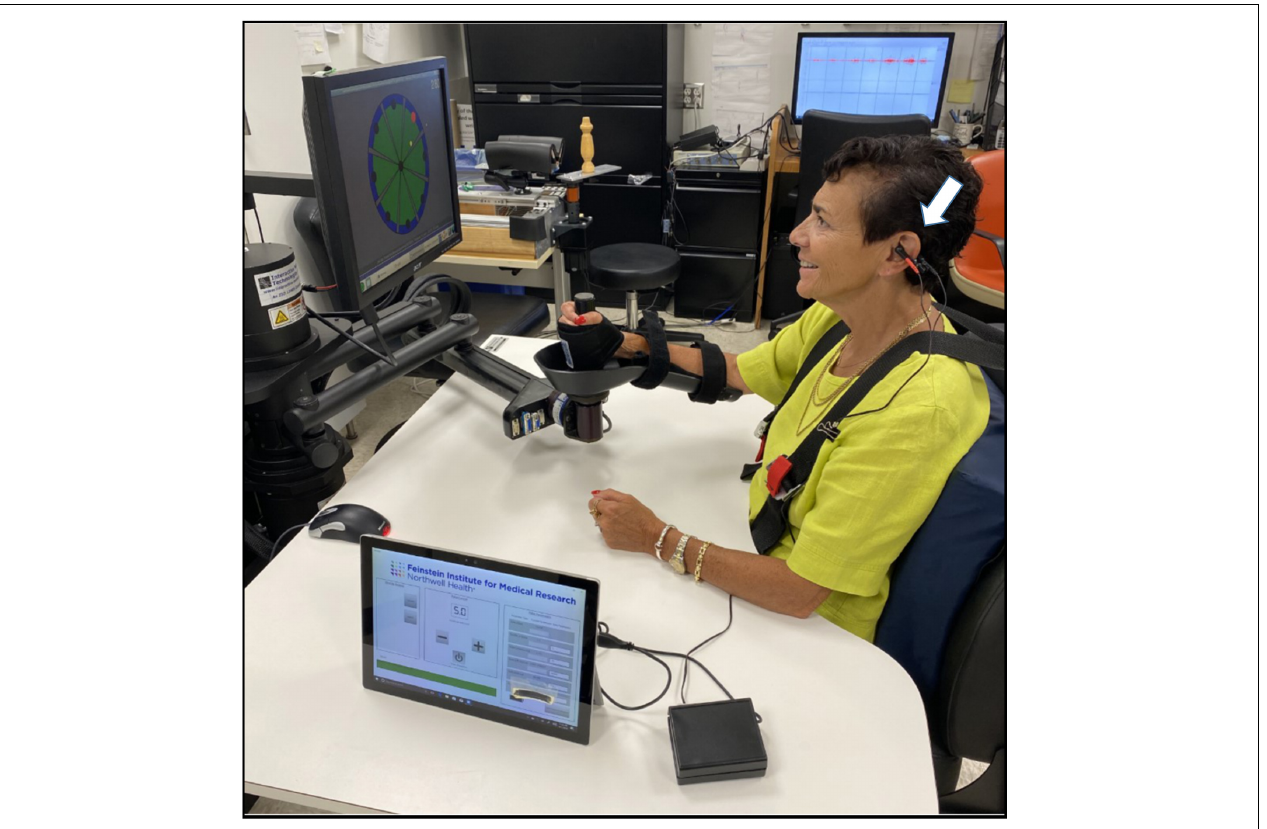
FIGURE 1 | Subject receiving taVNS (arrow marks the placement of the stimulator; single 500 ms bursts, 30 Hz, pulse width = 0.3 ms, intensity just below pain threshold between 0.1 and 5.0 mA) during the blinking visual cue for the onset of extension movements on the InMotion ARM R (cid:13) robot. During each 1 h session patients performed 1,024 active-assist center-out clock movements of the shoulder and elbow, and received stimulation during a total of 256 extensions movements (right = 9 o’clock, 10 o’clock, 12 o’clock, 2 o’clock; left = 10 o’clock, 12 o’clock, 2 o’clock, 3